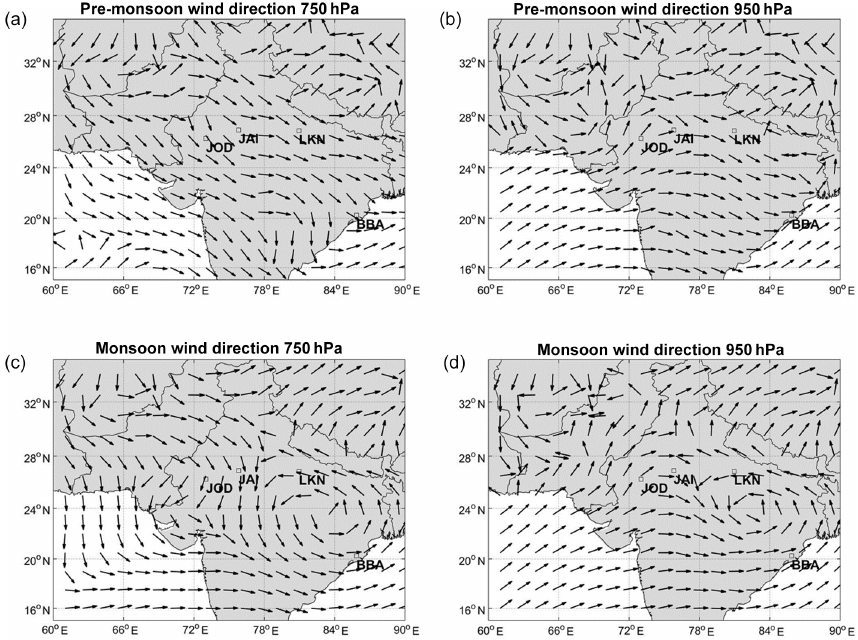
Figure A2. Mean wind direction conditions during the pre-monsoon (a, b) and monsoon seasons (c, d) . The data used in the maps are from ERA-Interim (Dee et al.,